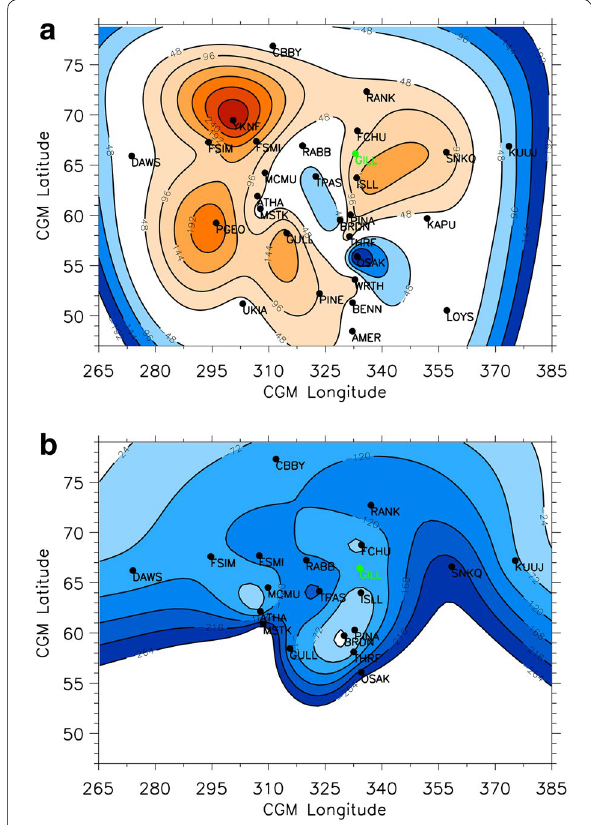
Fig. 5 A minimum curvature fit to the difference in onset times across the entire Canadian sector for ( a ) Pi2 and Pi1-2, where red (blue) represents Pi2 waves occurring first (second), and ( b ) Pi1 and Pi1-2, where blue represents Pi1 waves occurring second, with respect to Pi1-2 waves. The uncertainty in the relative timing between ULF wave bands is defined as the summation of each individual ULF wave band uncertainty. Hence, the timing uncertainties associated with each comparison are as follows: Pi1–Pi1-2 is 24 s, Pi1-2–Pi2 ± is 48 s. Any regions in white represent locations where the onset ± of ULF waves in each band is at the same time within the inherent uncertainties outlined here. Each relative timing analysis thus uses contours which start at the first resolvable timing difference outside these different uncertainties, and those that cannot be resolved are marked in